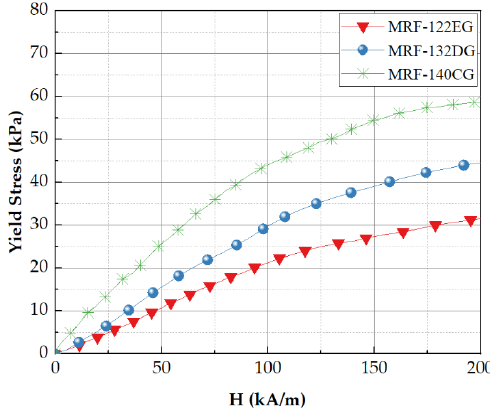
Figure 5. The field-dependent yield stress of various MRFs .